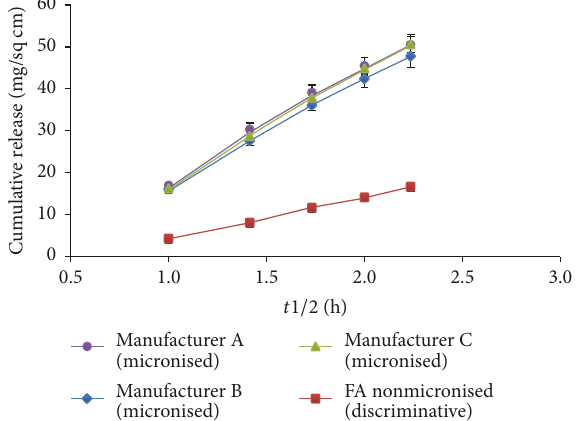
Figure 5: In vitro release profiles of FA from Fusicutan plus Betamethasone cream showing statistically comparable release rates for FA from all 3 drug substance